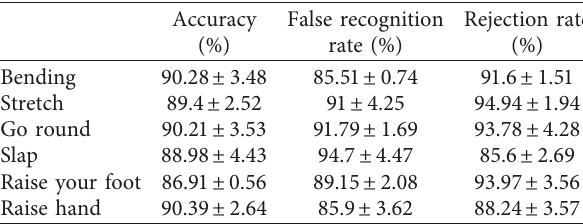
Table 2: Six types of behavior recognition results.